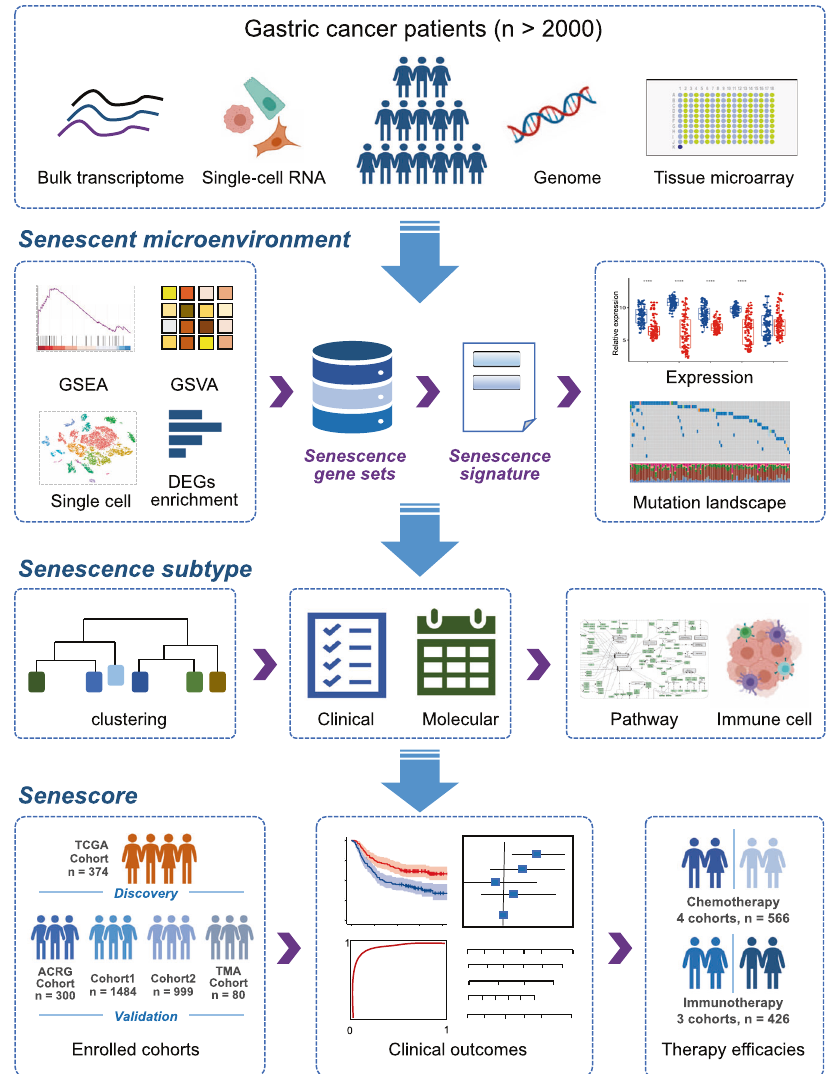
Fig. 1 Overview of the work fl ow in this study. Multiomics data ranging from bulk and single-cell transcriptome, genome to protein expression derived from more than 2000 gastric cancer patients were included in this pipeline analysis. Multiple bioinformatics algorithms including GSEA, GSVA, and differential expression analysis were applied to dissect senescent microenvironment and identify the senescence signature in gastric cancer. Moreover, the senescence subtype was established through the unsupervised clustering, and further was parsed in clinical and biological relevance. Finally, the senescence scoring system, senescore, was developed and validated for clinical prognosis and therapy ef fi cacies in wide spectrum of patient